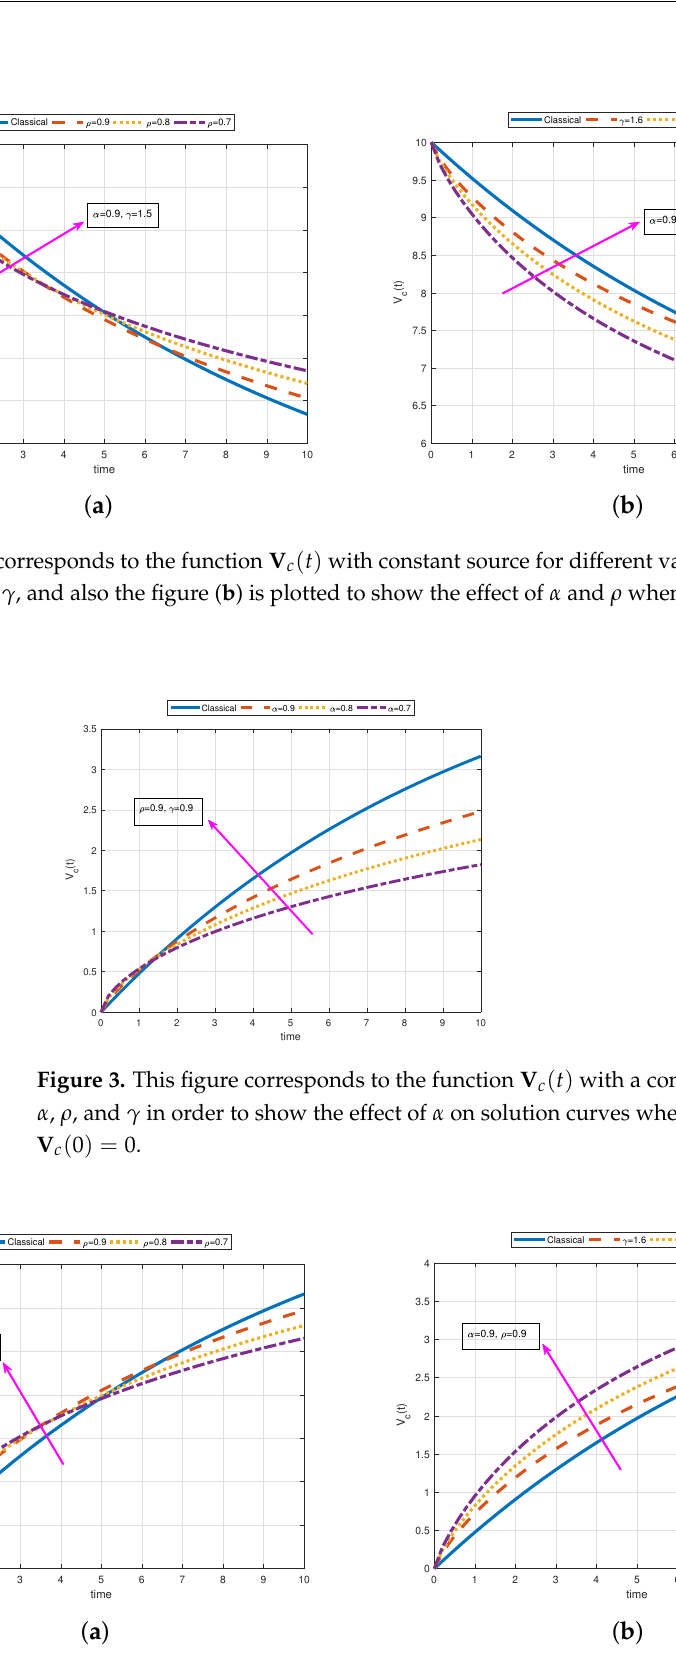
Figure 4. The figure ( a ) corresponds to the function V c ( t ) with constant source for different values of α , ρ , and γ in order to show the effect of α and γ , and also the figure ( b ) is plotted to show the effect of α and ρ when R = 1 Ω , C = 10 F, e 0 = 5 V, and V c ( 0 ) =